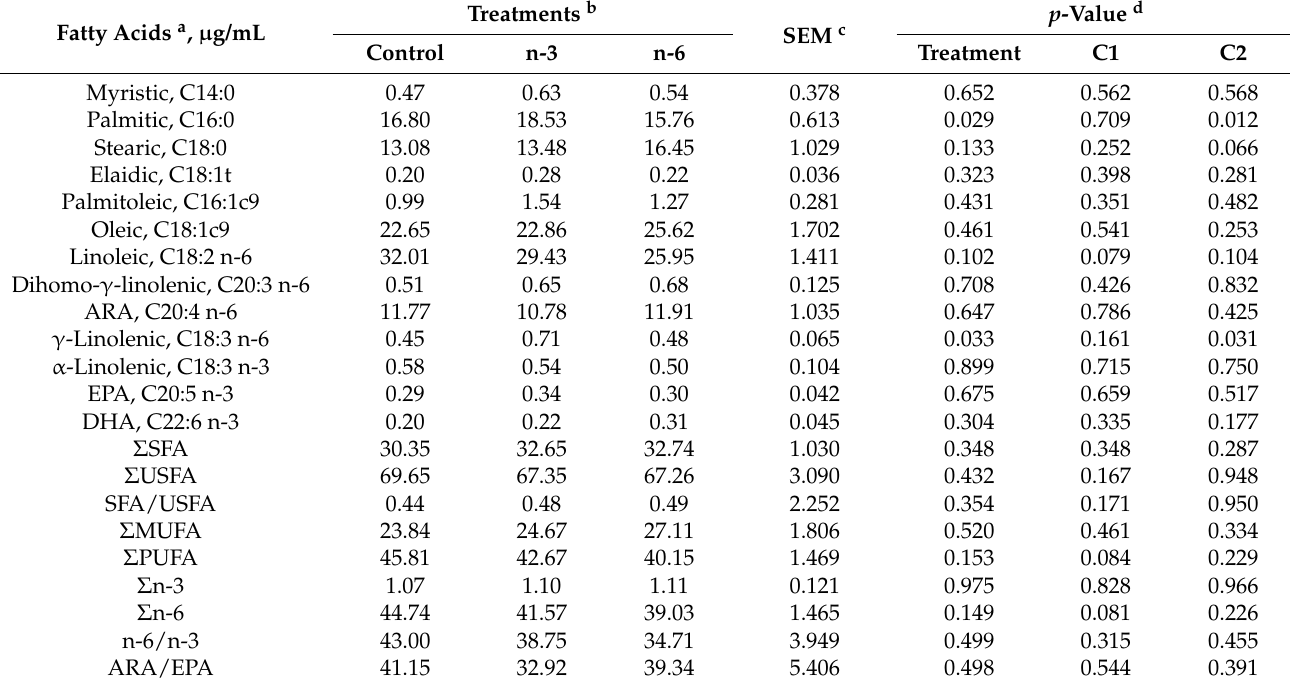
Table 5. Fatty acid profile of the serum of sows on the first day of